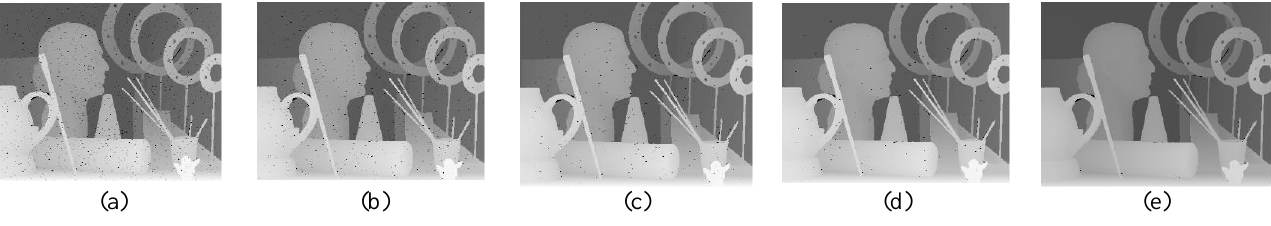
Figure. 6. Reliable depth map by the proposed method considering different thresholds (a) T=10 (b) T=5 (c)